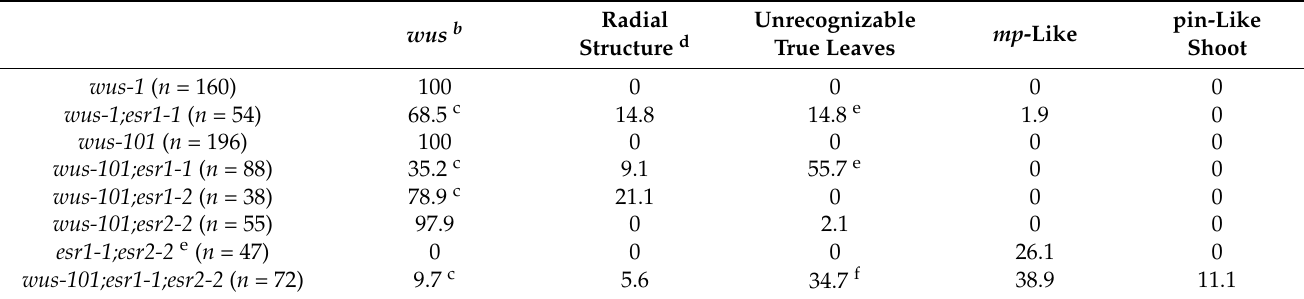
pin-Like mp -Like